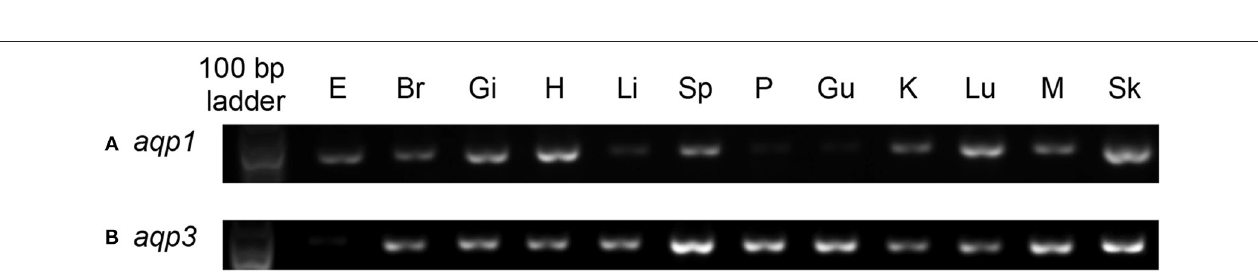
FIGURE 5 | The gene expression of (A) aquaporin 1 (aqp1) and (B) aquaporin 3 (aqp3) in various tissues/organs of Protopterus annectens . The mRNA expression of aqp1 and aqp3 were examined in the eyes (E), brain (Br), gills (Gi), heart (H), liver (Li), spleen (Sp), pancreas (P), gut (Gu), kidney (K), Lung (Lu), muscle (M), and skin (Sk), of Protopterus annectens kept in fresh